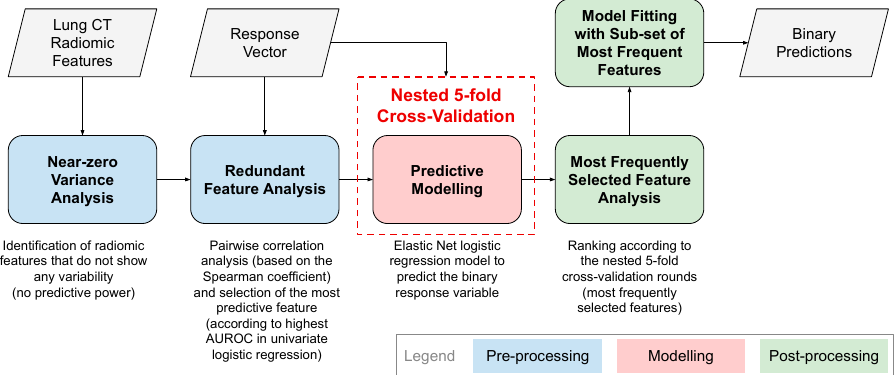
Figure 1. Overall workflow for the development of LDCT radiomic automatic classifiers for PNs. All data analyses were performed using the MatLab ® R2019b (64-bit version) environ- ment (MathWorks, Natick, MA, USA). The evaluation metrics used were the area under